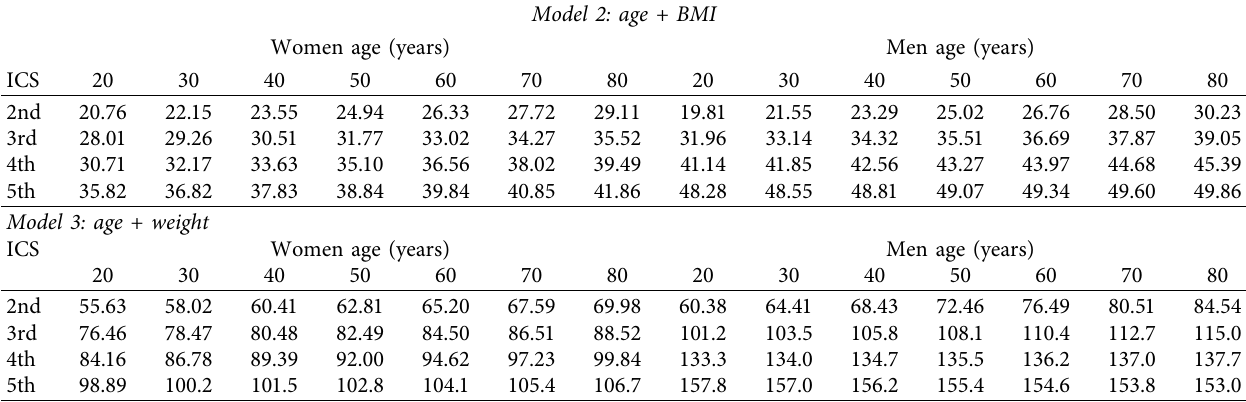
Table 7: BMI chart for Model 2 and weight chart for Model